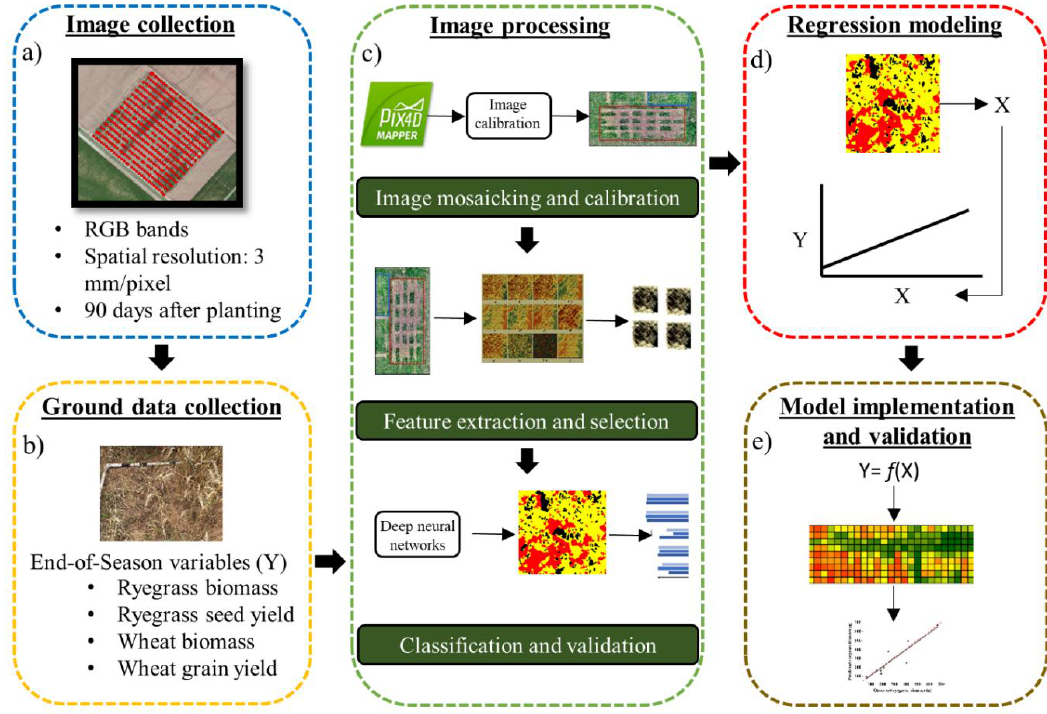
Figure 2. Flowchart for the overall methodology followed in this research for detecting Italian ryegrass in wheat and prediction of competitive interactions. The specific steps included (shown in dashed boxes) are: ( a ) image collection, ( b ) ground data collection, ( c ) image processing, ( d ) regression modeling, ( e ) model implementation and validation.